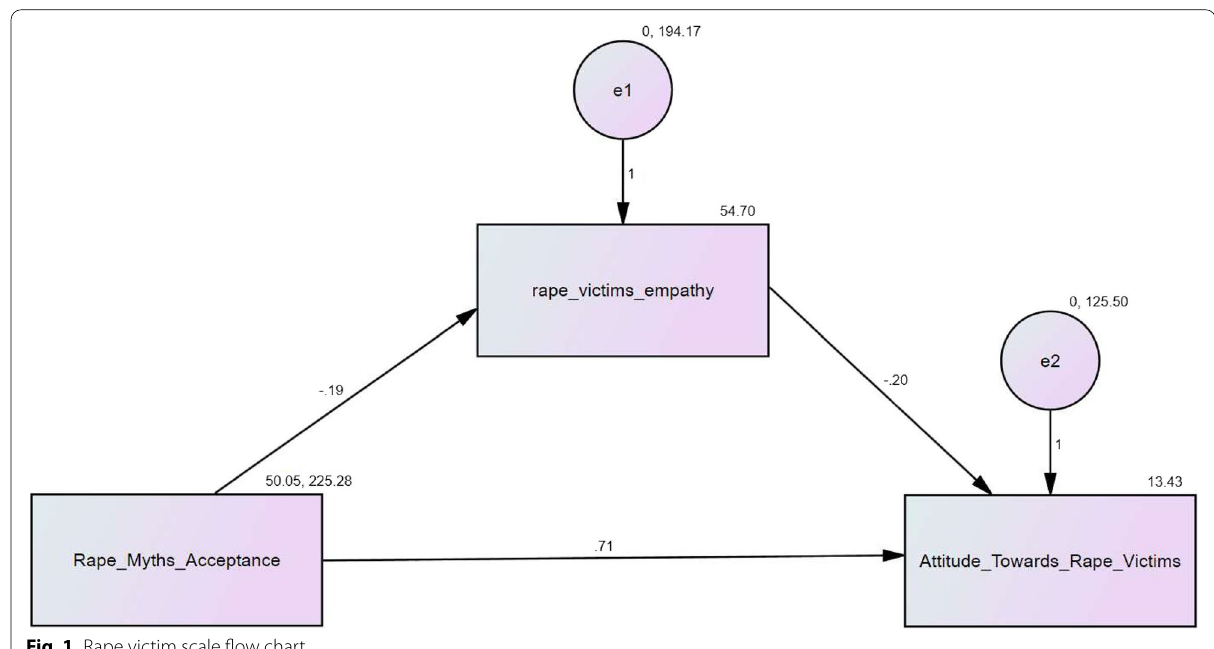
Fig. 1 Rape victim scale flow